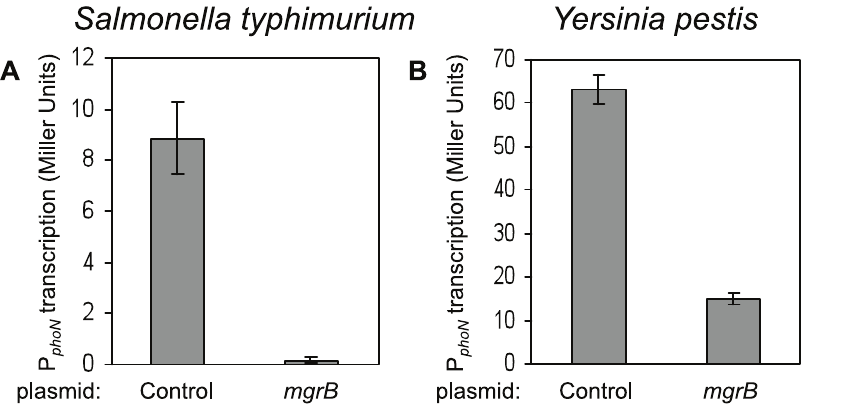
Figure 7. Inhibition of PhoP-regulated transcription by MgrB in Salmonellatyphimurium and Yersiniapestis . (A) Salmonella enterica serovar Typhimurium strain 14028s carrying the P phoN - lacZ reporter plasmid pNL2 and either a plasmid expressing Salmonella mgrB (pAL43) or a control plasmid (pEB52) were grown in LB with antibiotics and 1 mM IPTG. The amino acid sequence of MgrB from strain 14028s (data not shown) is identical to the sequence from strain LT2 (shown in Figure 6). (B) Y. pestis KIM6 carrying pNL2 and either a plasmid expressing the Yersinia pestis mgrB (pAL42) or a control plasmid (pEB52) were grown in BHI with antibiotics and 1mM IPTG. For each strain, the mean and standard deviation for at least three independent cultures are shown.